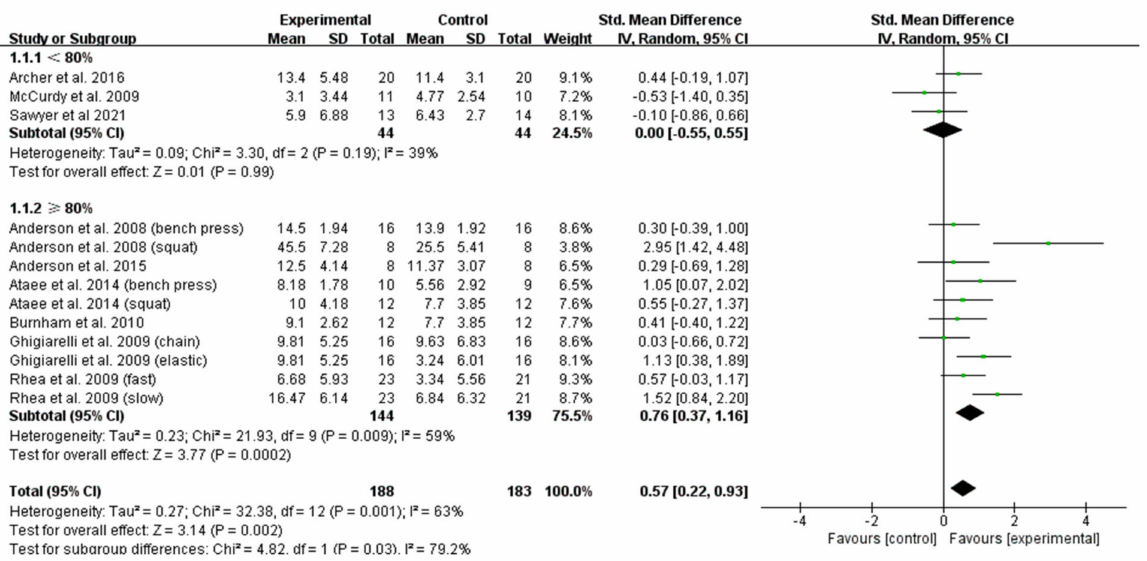
Figure 3. Forest plot of maximum-strength development: comparison between VRT and CRT after sensitivity analysis in trained subjects.